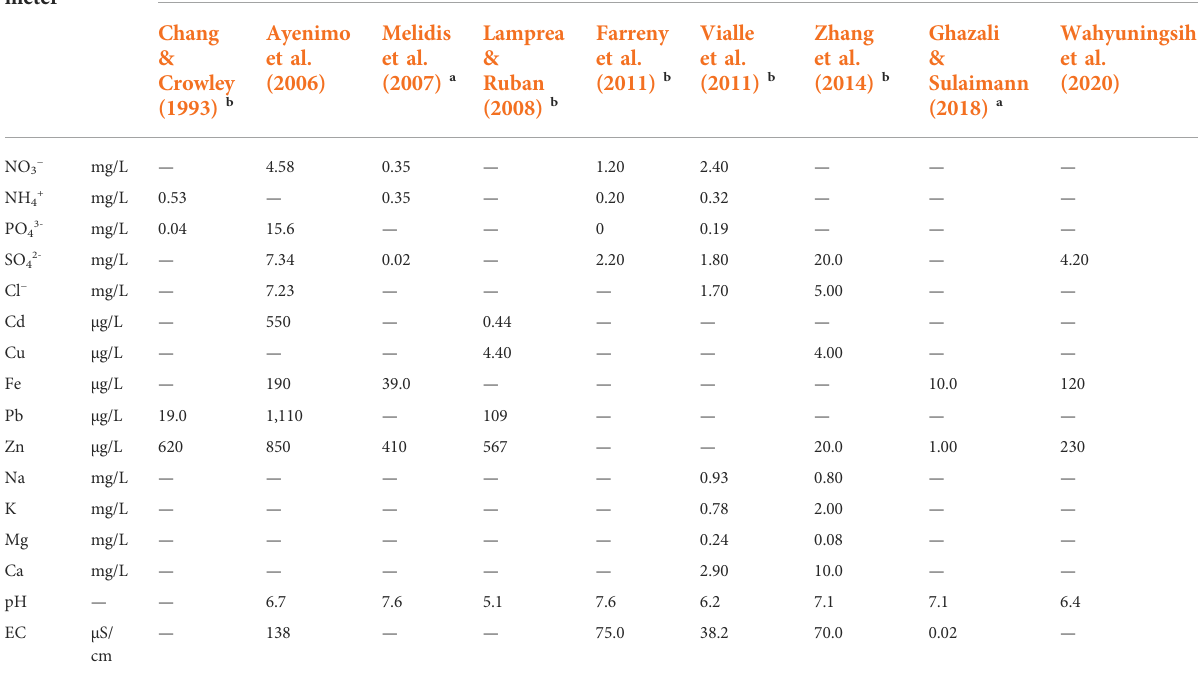
TABLE 8 Values of different parameters in clay tile roof runoff. Para-